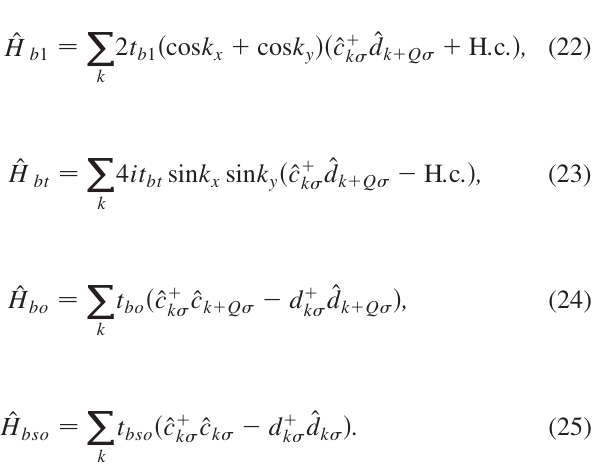
¼ 0 : 05 in Eq. (25). Other parameters are the same as in bso